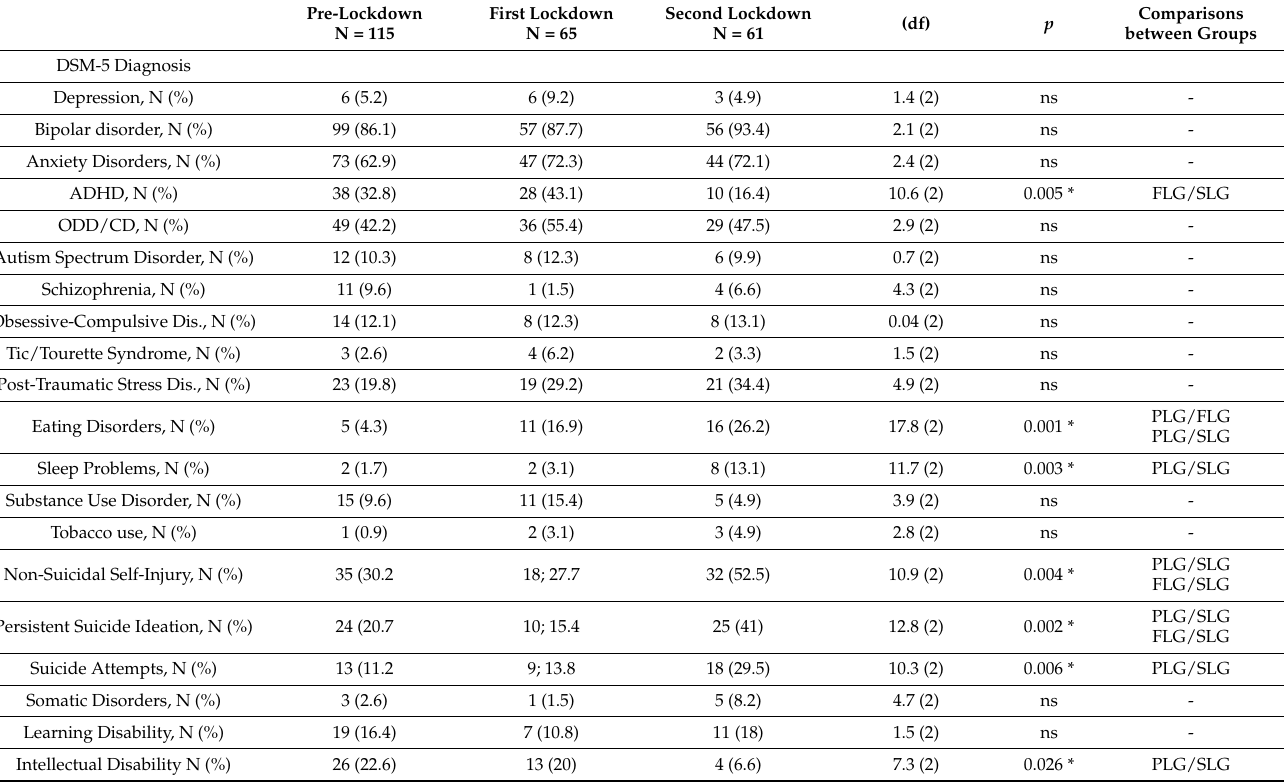
Table 1. Comparison between Pre-Lockdown (n = 115), First Lockdown (n = 65), and Second Lockdown (n = 61) groups: Categorical diagnoses (according to the DSM-5